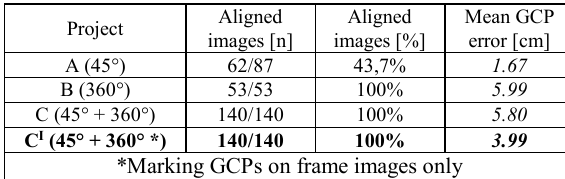
Table 5. Processing parameters of the different dataset. Number and percentage of successfully aligned images for each dataset are reported as well.